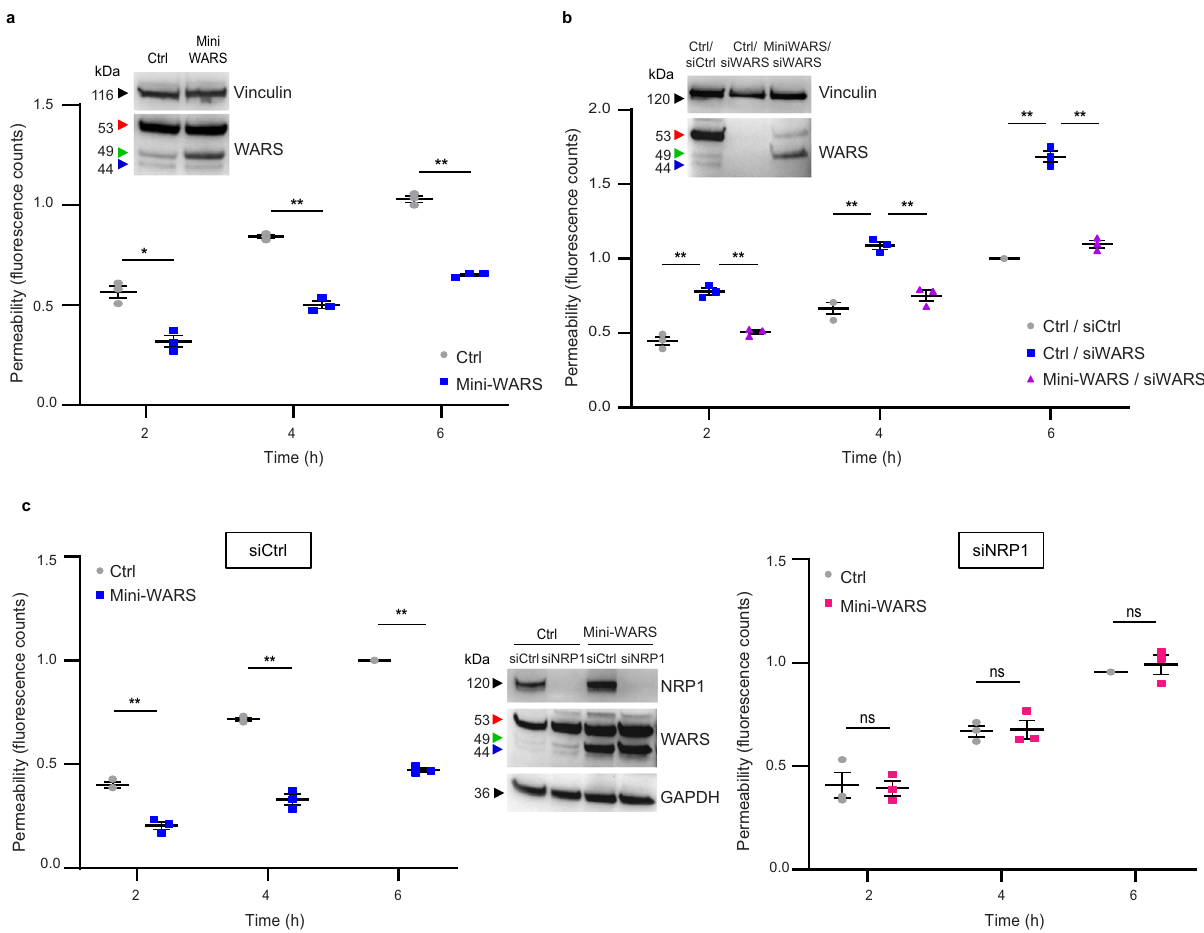
Fig. 6 Mini-WARS is an extracellular inhibitory NRP1 ligand that impairs histamine-elicited endothelial permeability. a Mini-WARS overexpression decreases histamine-elicited endothelial permeability. Quanti fi cation of 70 kDa Dextran-FITC transendothelial fl ux over time through a con fl uent Ctrl (empty lentivirus) or mini-WARS-transduced EC monolayer after histamine stimulation. Data are the mean ± SEM of three independent